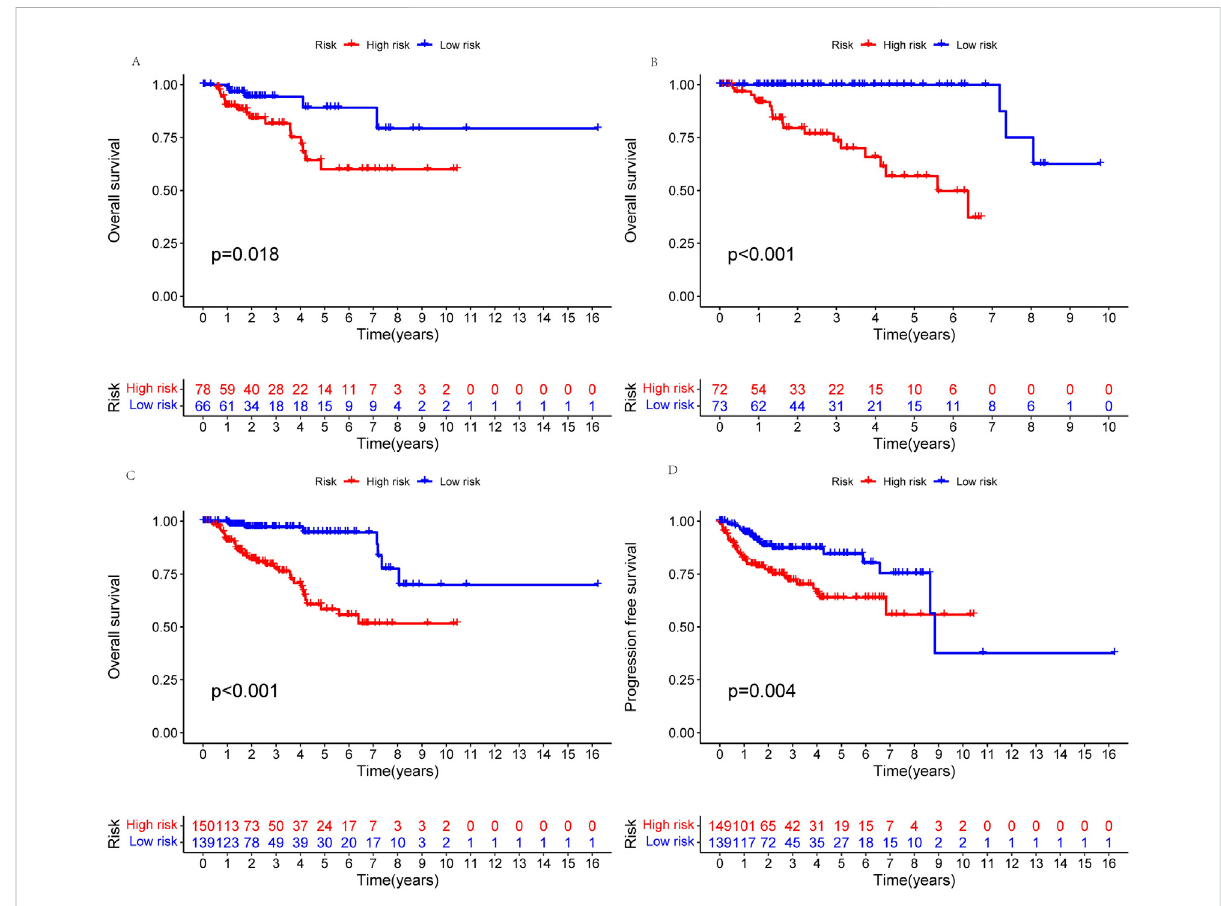
FIGURE 3 Kaplan-Meier survival analyses of patients. Patients were divided into high-risk and low-risk groups based on the median risk score to predict overallsurvival(OS)andprogression-freesurvival(PFS)ineachsubgroup. (A) OSinthetestinggroup. (B) OSinthetraininggroup. (C) OSinallgroups. (D) PFS in all